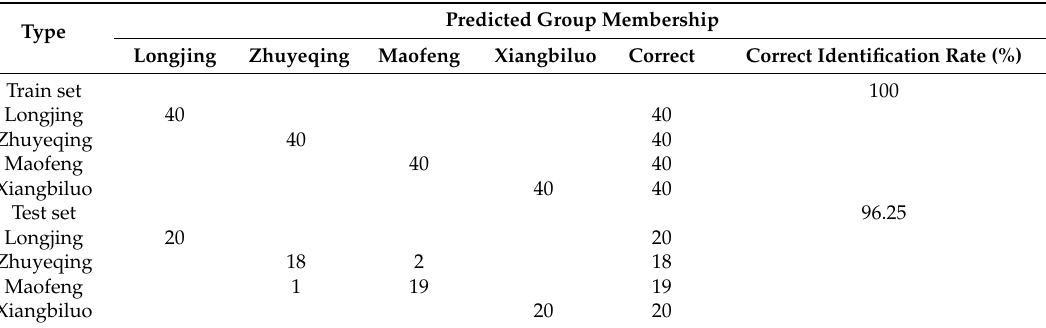
Table 3. Classification results of GA-SVM.